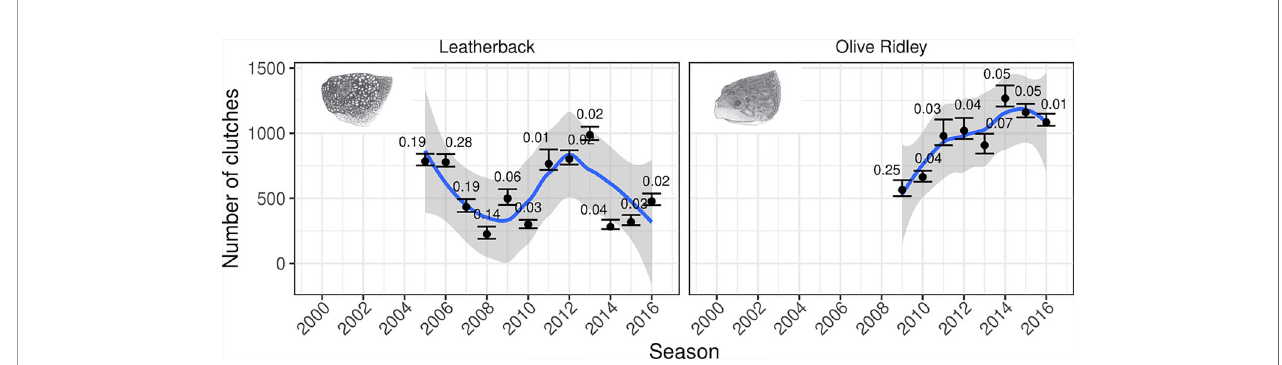
FIGURE 3 | Predictions for the number of clutches for leatherback and olive ridley turtles each season between 2000/2001 and 2016/2017. The points correspond to the posterior predictive mean estimates for the total number of clutches in that season, aggregated across all sites, with the error bars corresponding to the 95% prediction intervals. The number above the error bars correspond to the proportion of the clutches estimated in each season. We have removed any season with a posterior mean of > 30% of the total clutches being estimated. The trend lines correspond to loess-smoothed fi ts through the posterior means, with the grey ribbons depicting the 95% con fi dence intervals for the smoothed fi ts. This plot corresponds to Figure S4 in the supplemental material which shows the results of a sensitivity analysis where we used a less informative range on the peak nesting effort to determine the impact of our prior